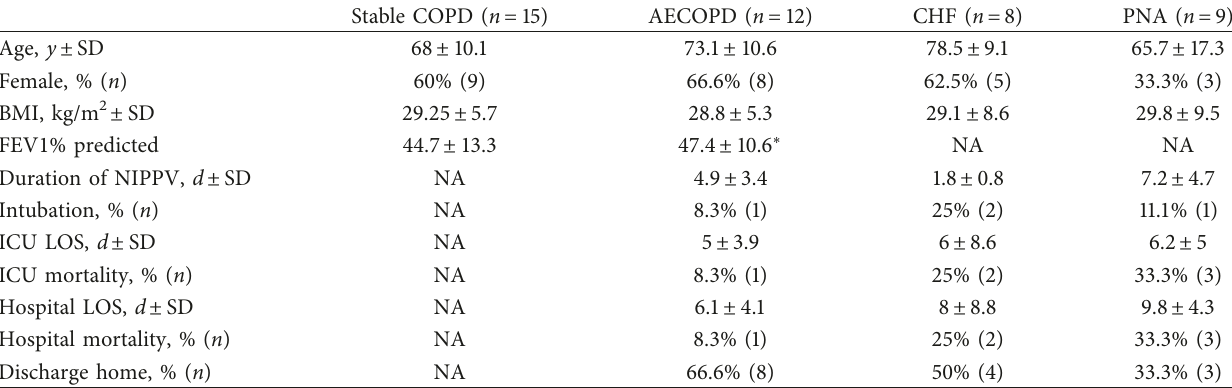
Table 1: Subjects